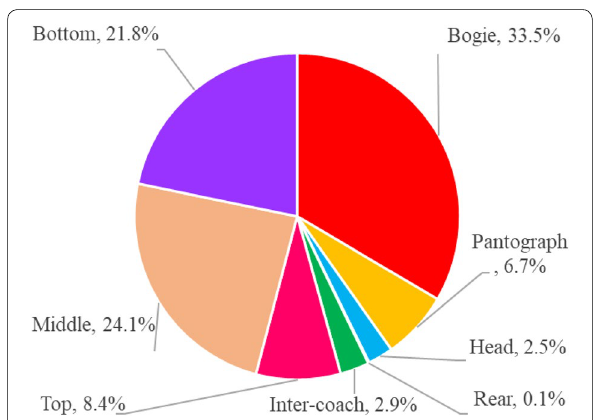
Figure 4 Contributions to the total sound power from different areas of the train